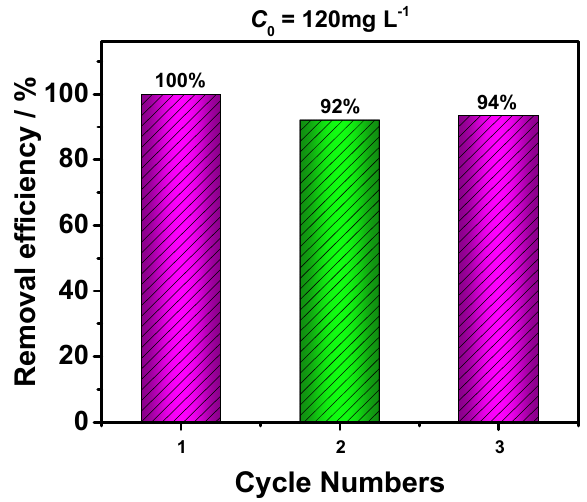
Figure 10. Recycling ability of the Co–SiO 2 (0.17) catalyst.